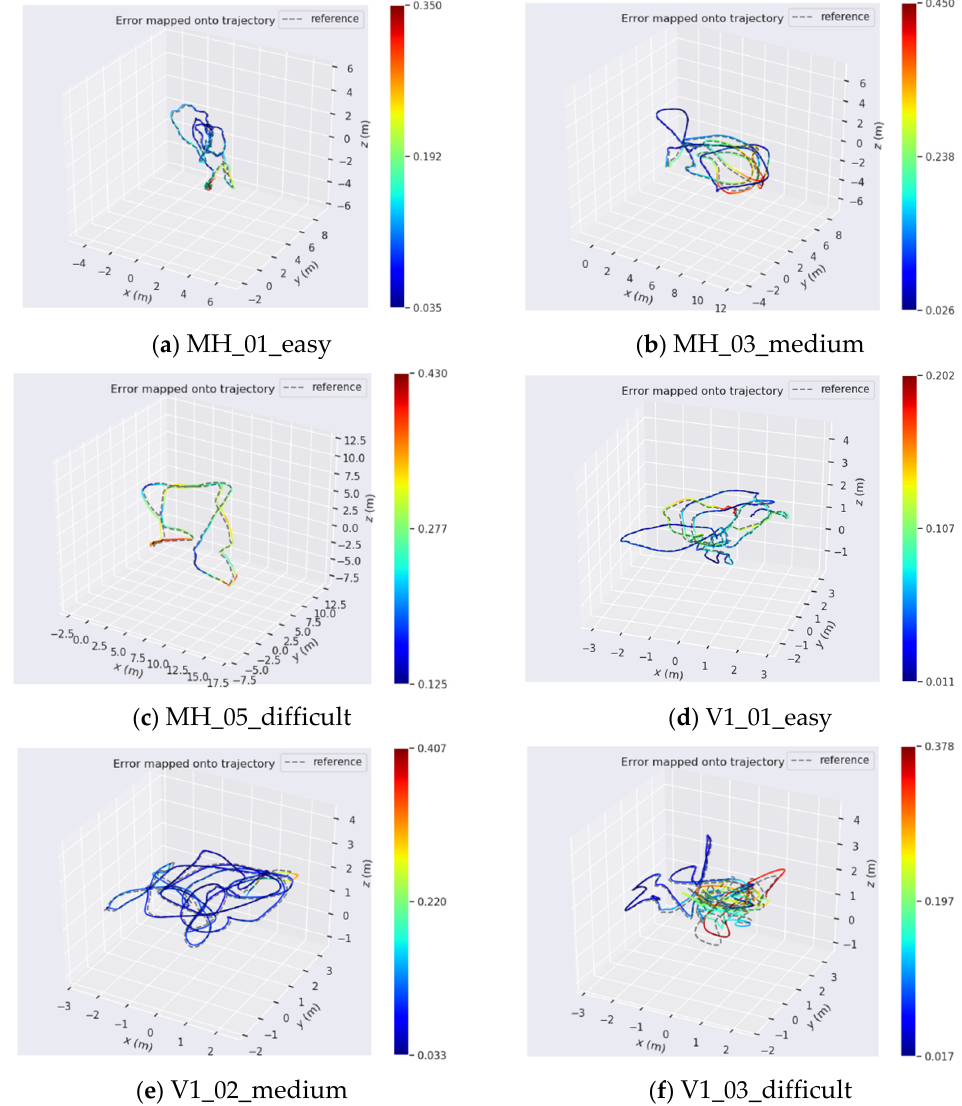
Figure 12. Comparison of trajectory error.